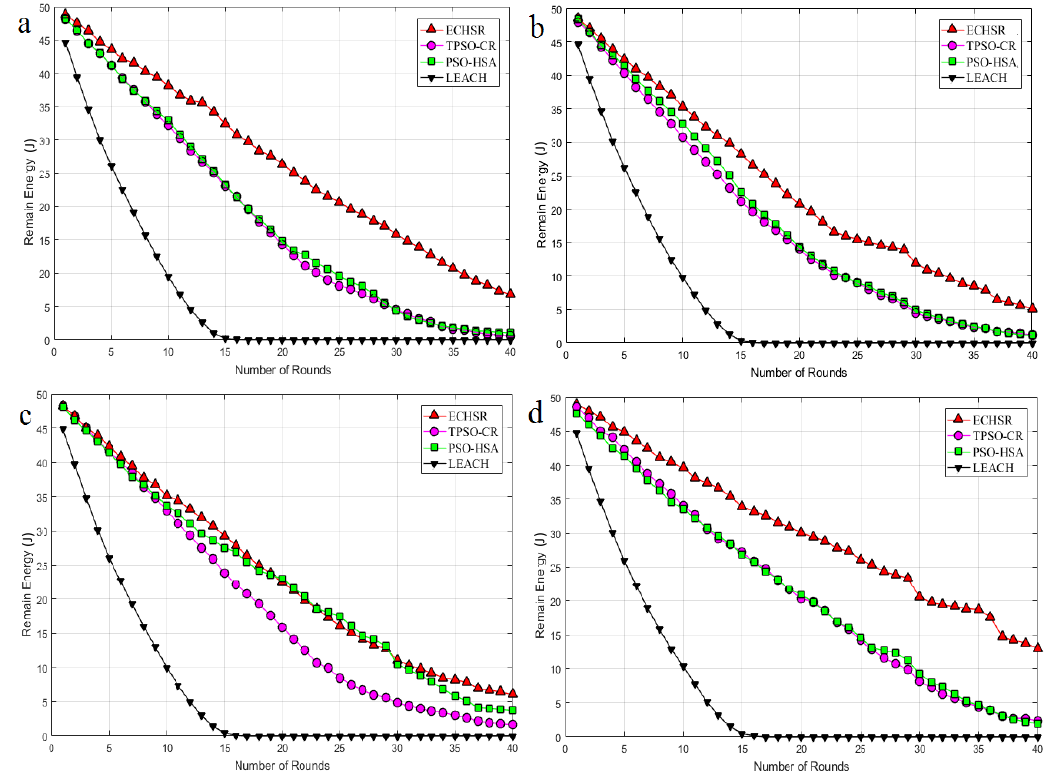
Figure 8. The residual energy for sink locations ( a ) (100, 100), ( b ) (0, 100), ( c ) (50, 150), and ( d ) (50,